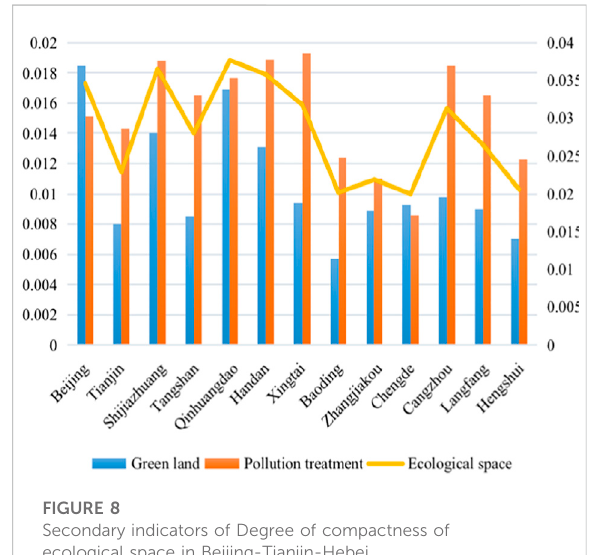
FIGURE 8 Secondary indicators of Degree of compactness of ecological space in Beijing-Tianjin-Hebei.